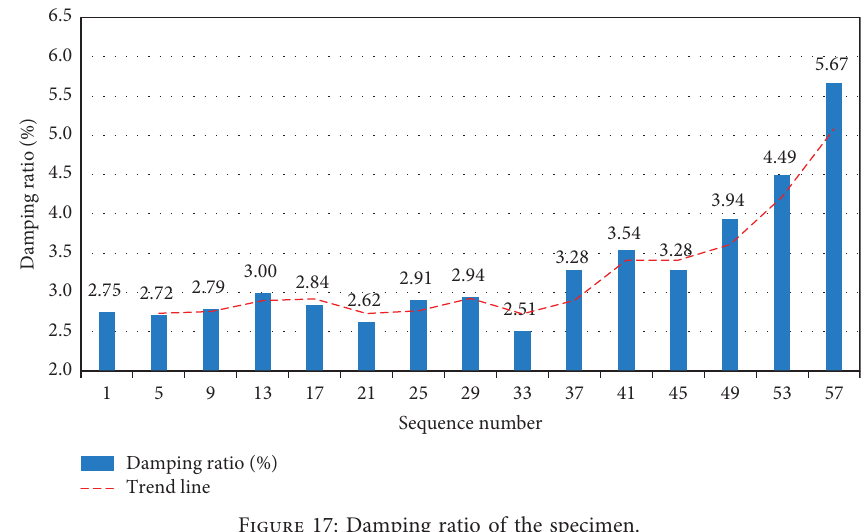
Figure 17: Damping ratio of the specimen.